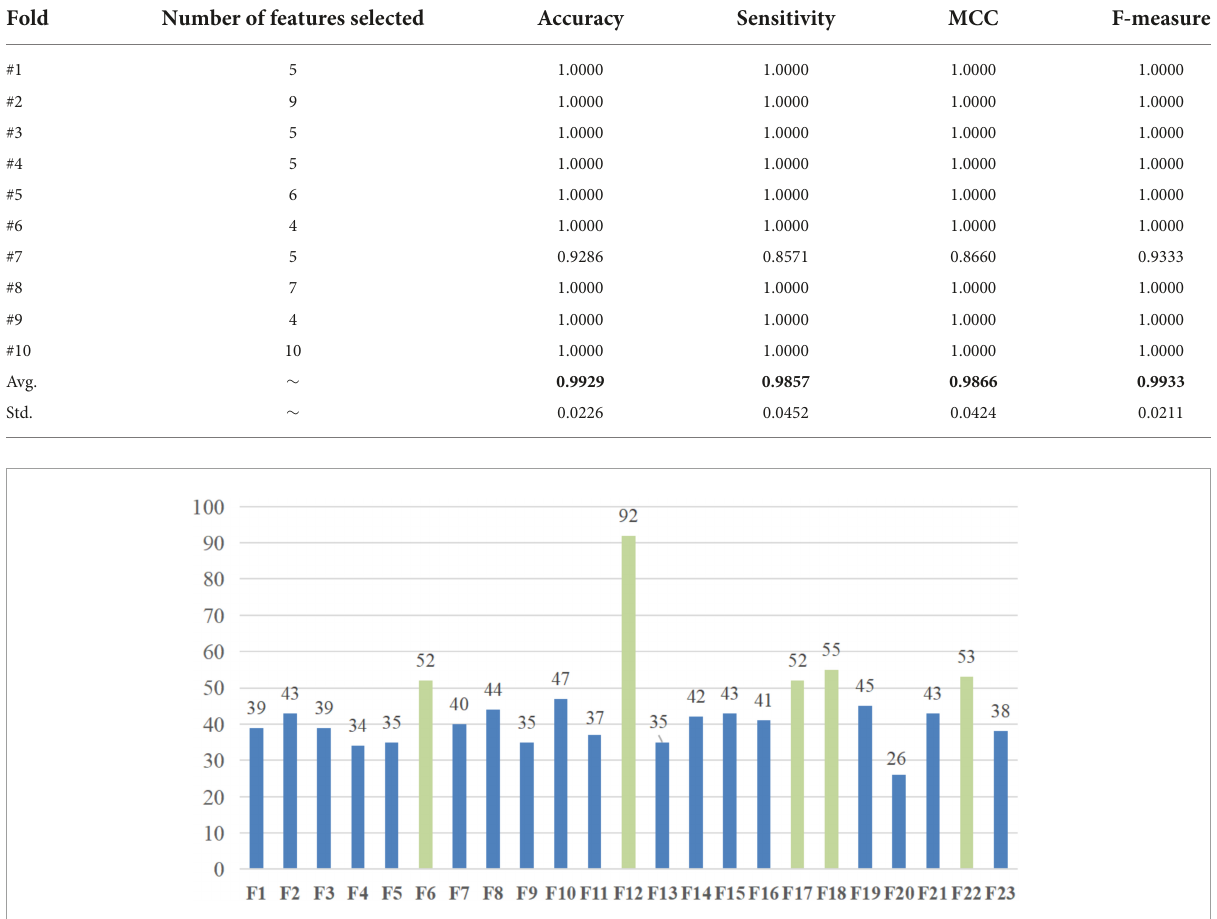
FIGURE9 Selected features of the bSBCS method in the 10 times 10-fold CV